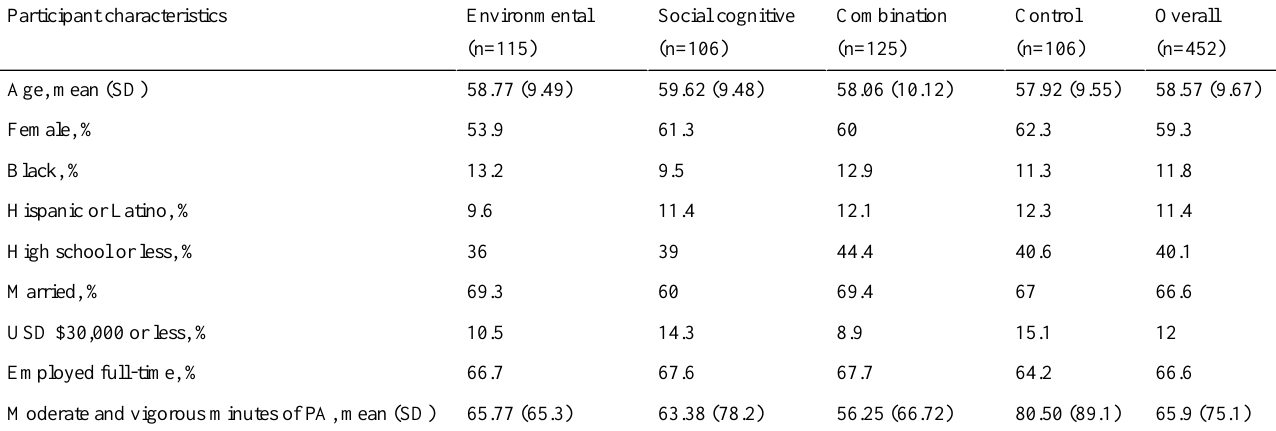
Table 1. Participant characteristics at baseline. a